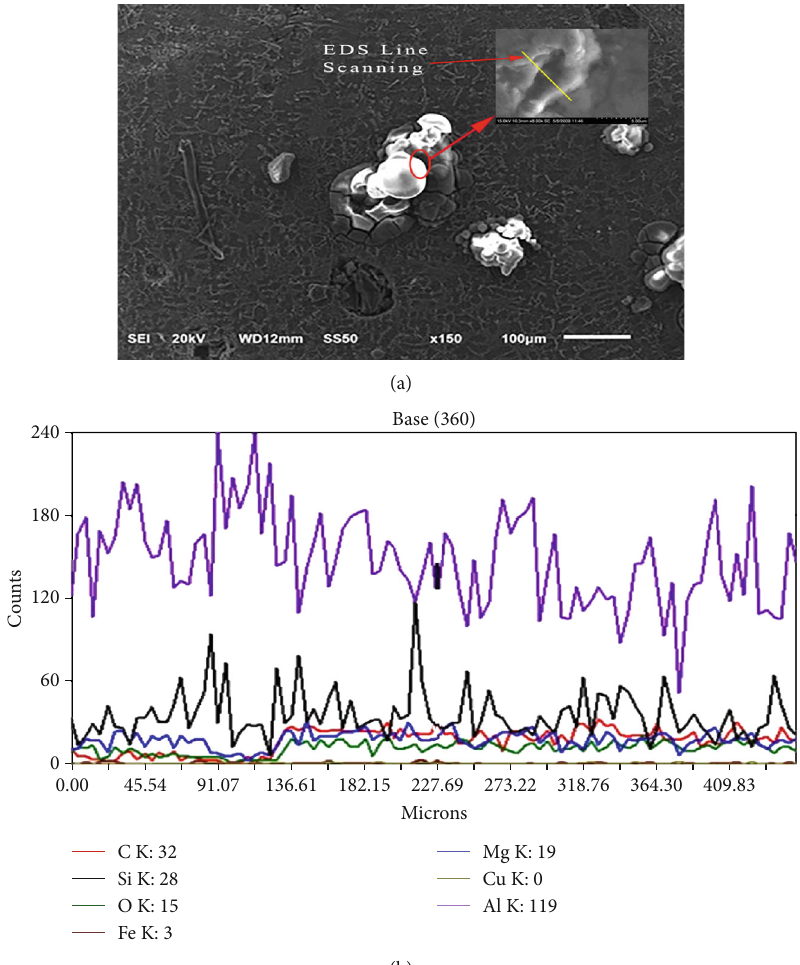
Figure 6: (a) SEM image of Al/GO composite; (b) EDS analysis.